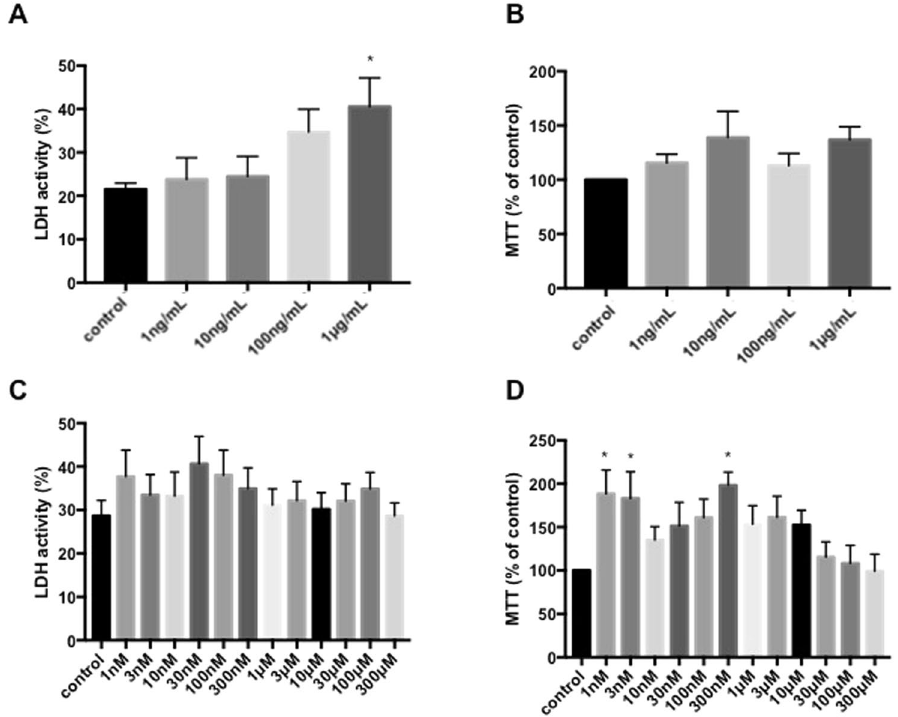
Figure 1. Effects of LPS and OUA in cell viability. ( A ) LDH activity of primary cultures of glial cells after 24 hours of LPS (1 ng/mL to 1 µ g/mL) treatment ( * p < 0.05). ( B ) MTT assay of the same cells used for LDH assay were incubated with MTT for 150 minutes, and the results were calculated by the percentage of each sample compared with the control group (n = 6). ( C ) LDH activity of primary cultures of glial cells after 24 hours of treatment with different OUA concentrations (1 nM-300 µ M). ( D ) MTT assay of the same cells used for the LDH assay were incubated with MTT for 150 minutes, and the results were calculated by the percentage of each sample compared with the control group (n = 9) ( * p < 0.05).